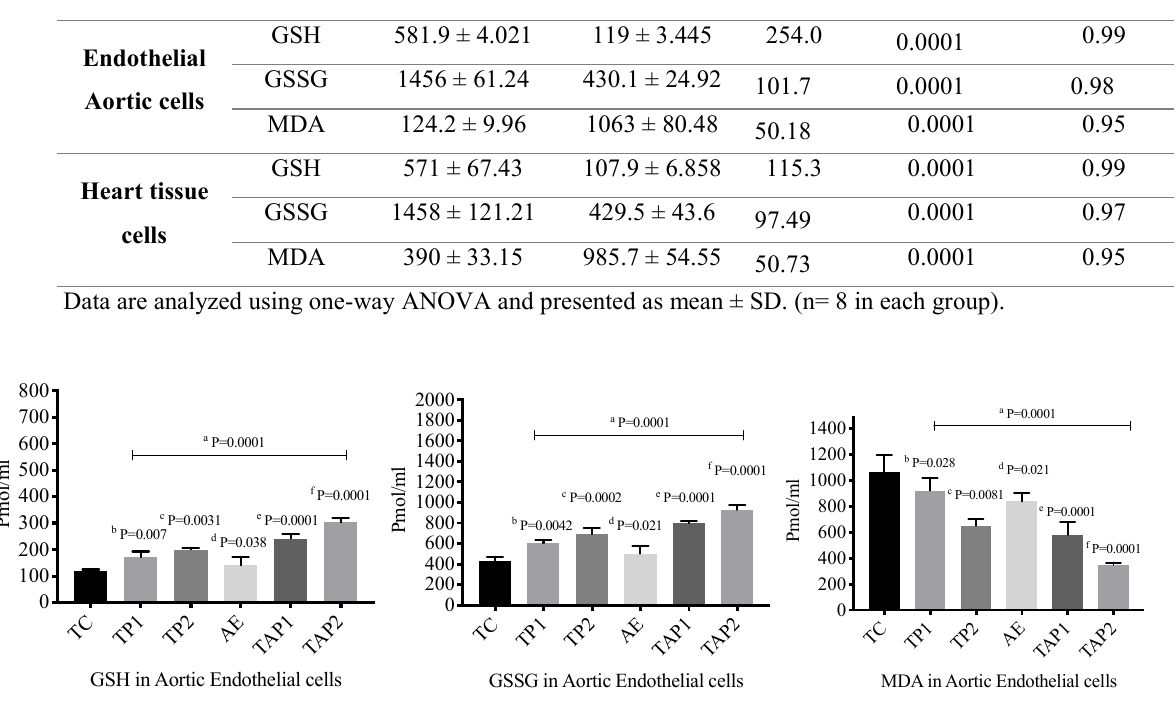
Table 1: Difference in the variables between the healthy-control and toxic–control groups. Variables (pmol/ml) Healthy-control